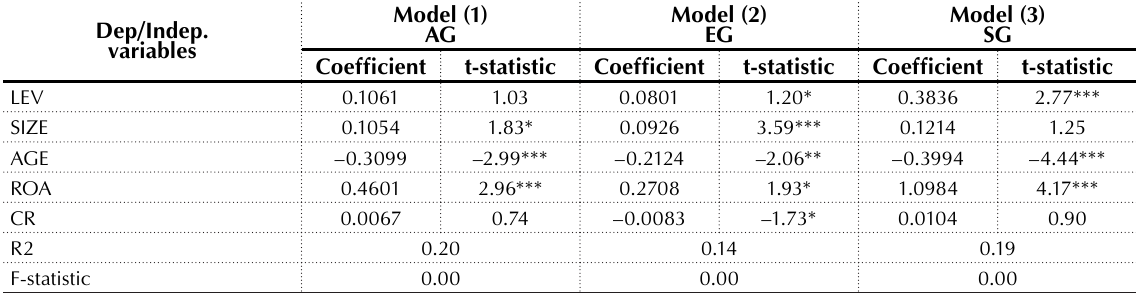
Table 2. Regression